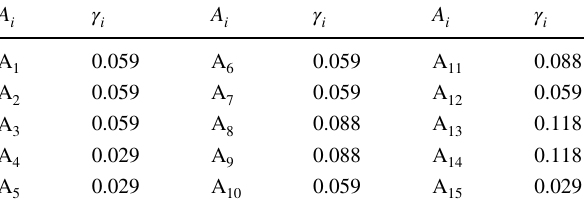
Table 6 Weight of potential disaster-affected points